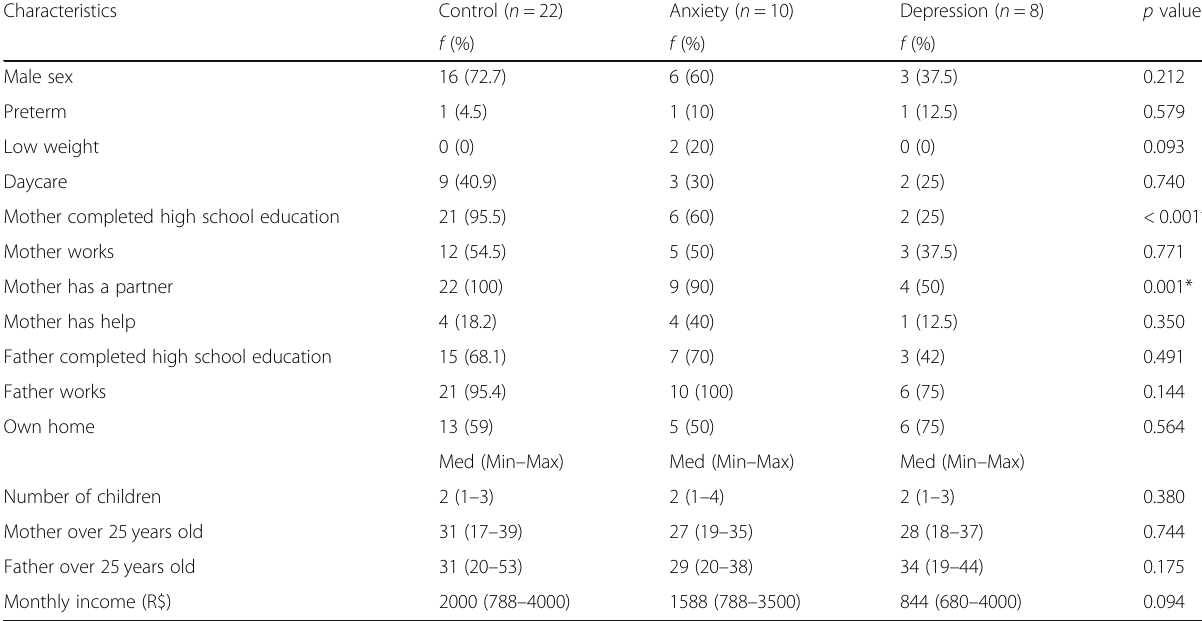
Table 1 Comparison of the sociodemographic and birth characteristics in the three groups Characteristics